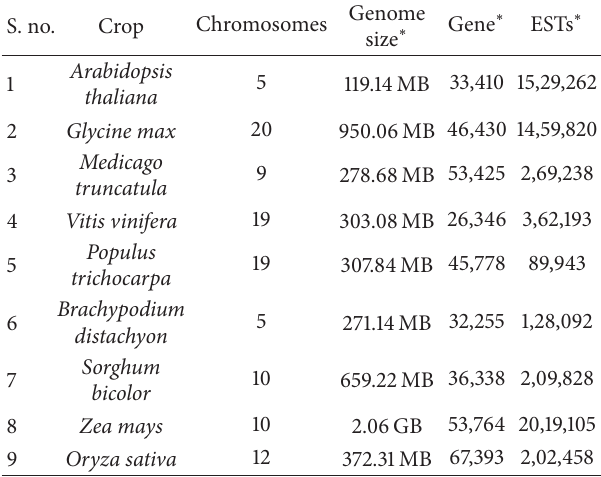
Table 1: List of plant species, chromosome number, genome size, and number of genes and